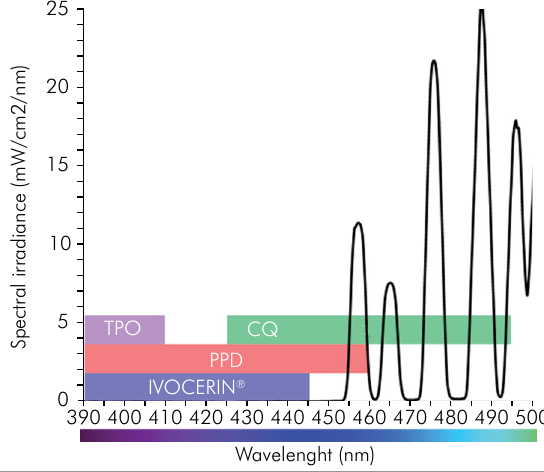
Figure 21. Spectral emission profile of an argon-ion laser curing light with absorption wavelength ranges for typical dental